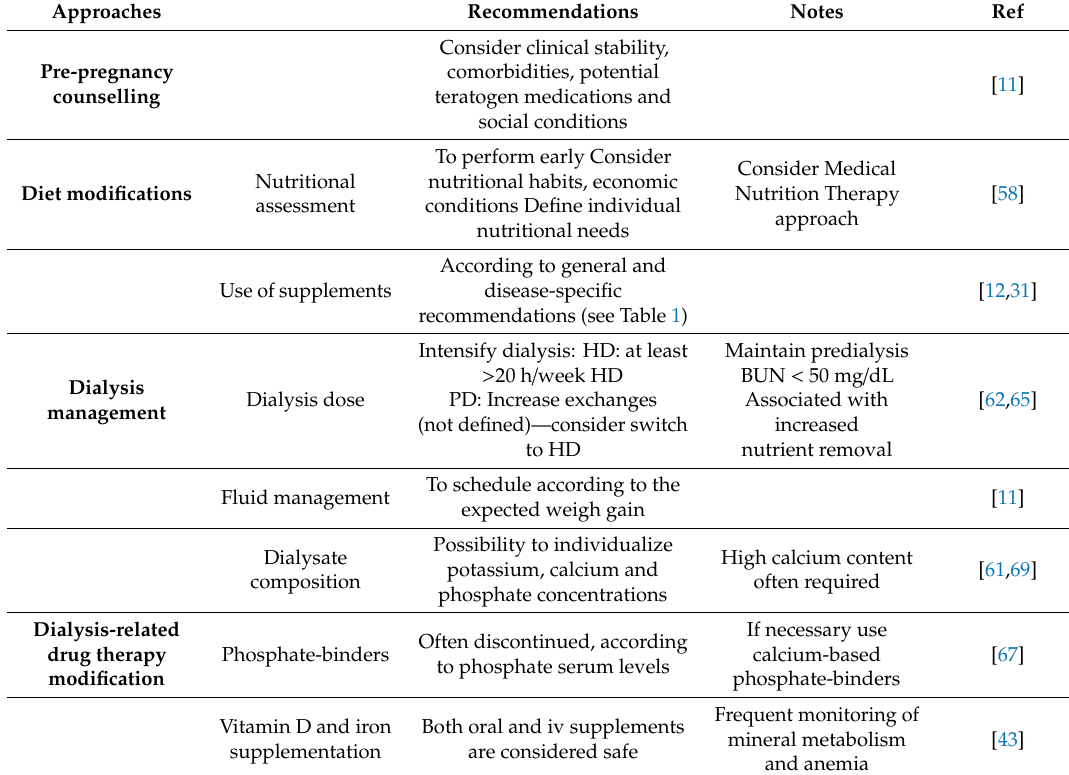
Table 2. Strategies to support nutritional status in pregnant women on